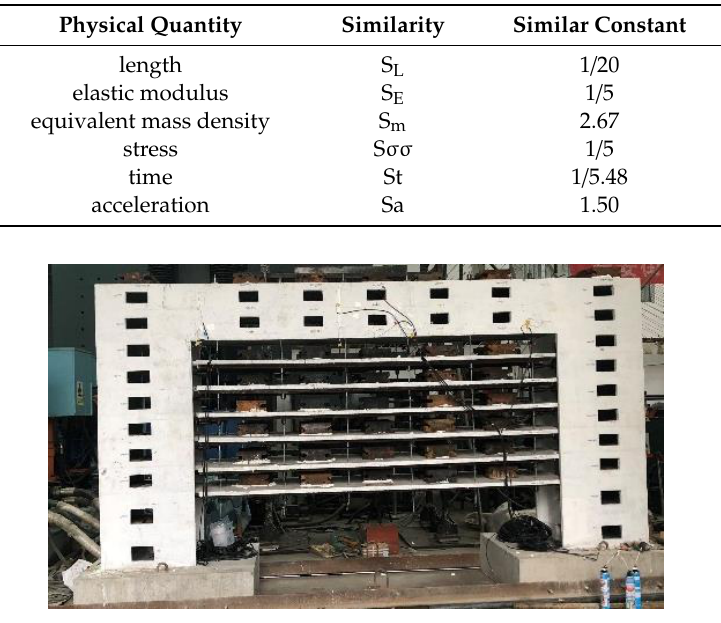
Figure 4. Experimental model.